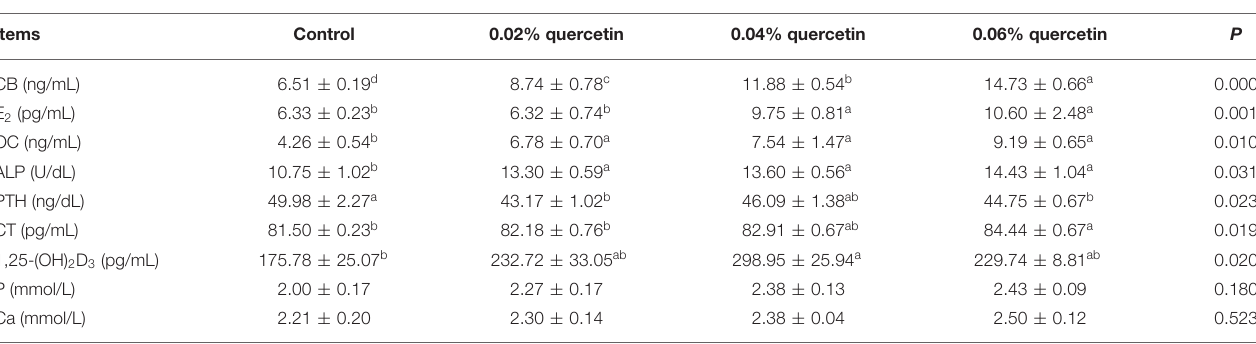
TABLE 5 | Effect of quercetin on serum biochemical parameters in broilers.